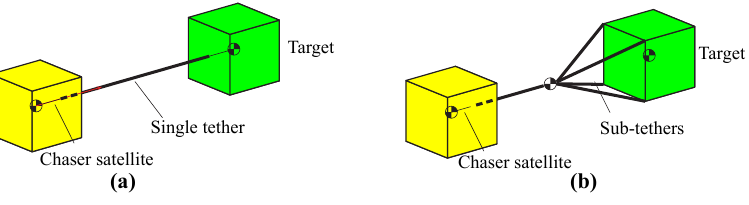
Figure 3. Configurations of a tethered system